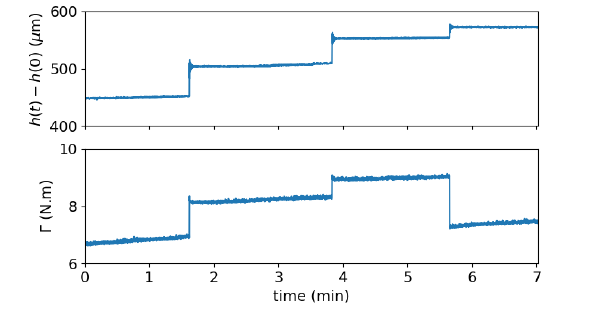
Figure 3. Sudden variations in h are simultaneous with sudden variations in resisting torque Γ